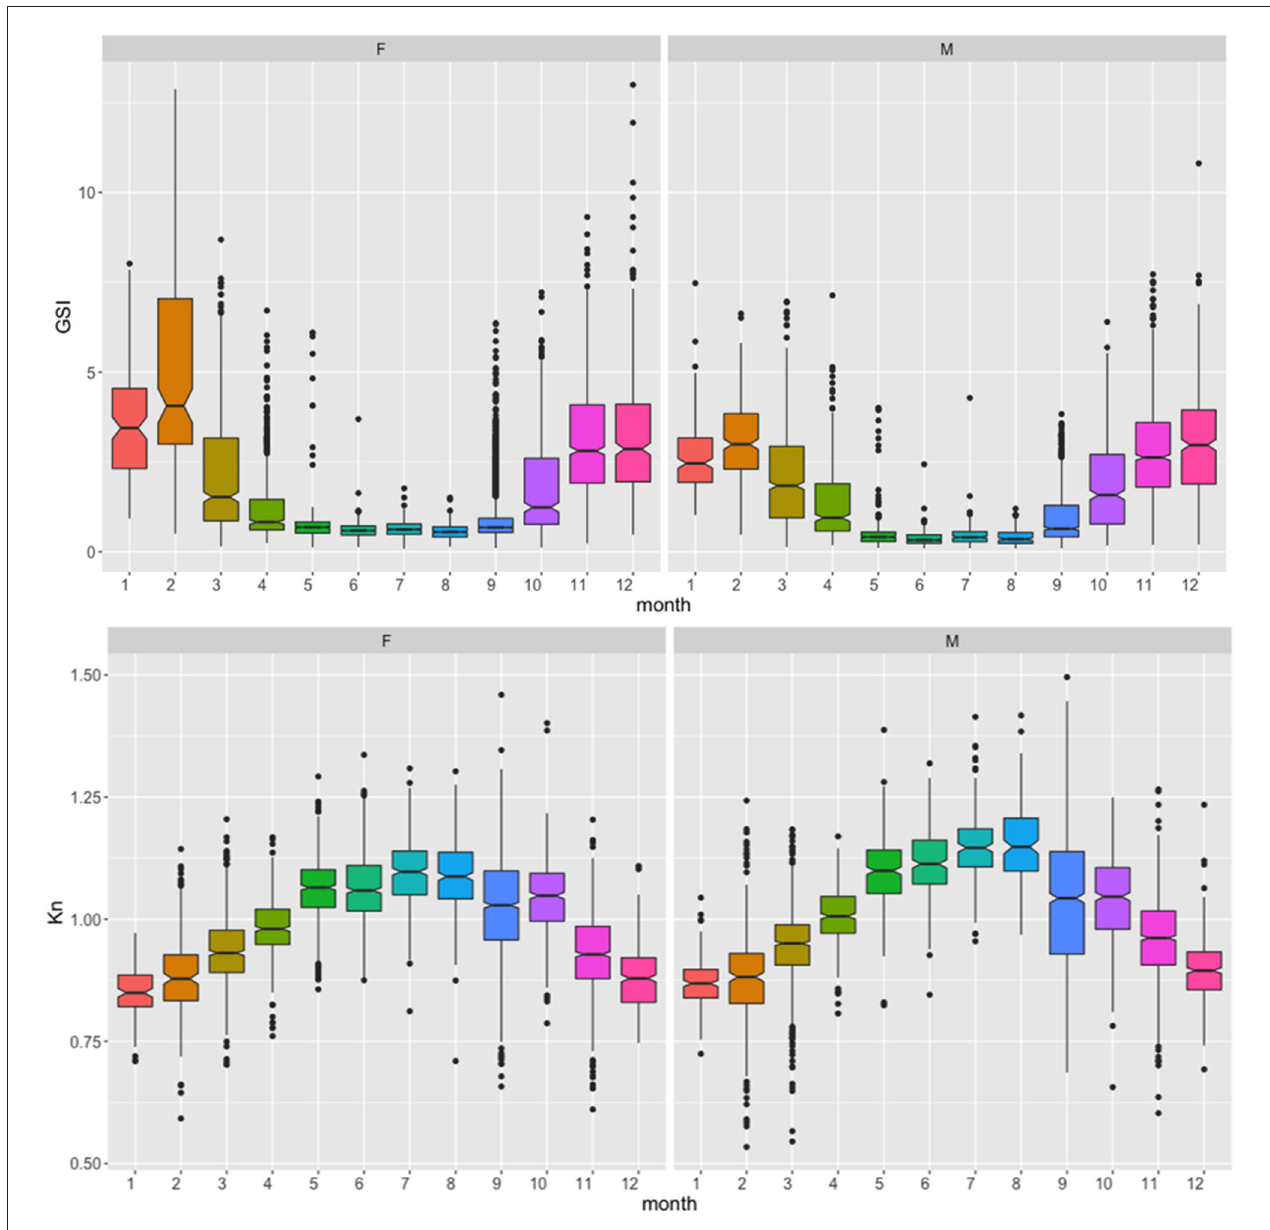
FIGURE 3 | Average monthly gonadosomatic index (GSI) and body condition index ( K n ) for female (F) and male (M) European sardine, along the study period in the Strait of Sicily. Notches are used to compare groups; if the notches of two boxes do not overlap, this suggests that the medians are significantly different.